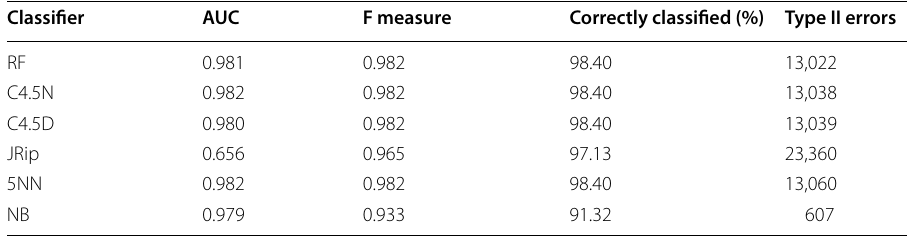
Table 9 Single-attribute evaluator results